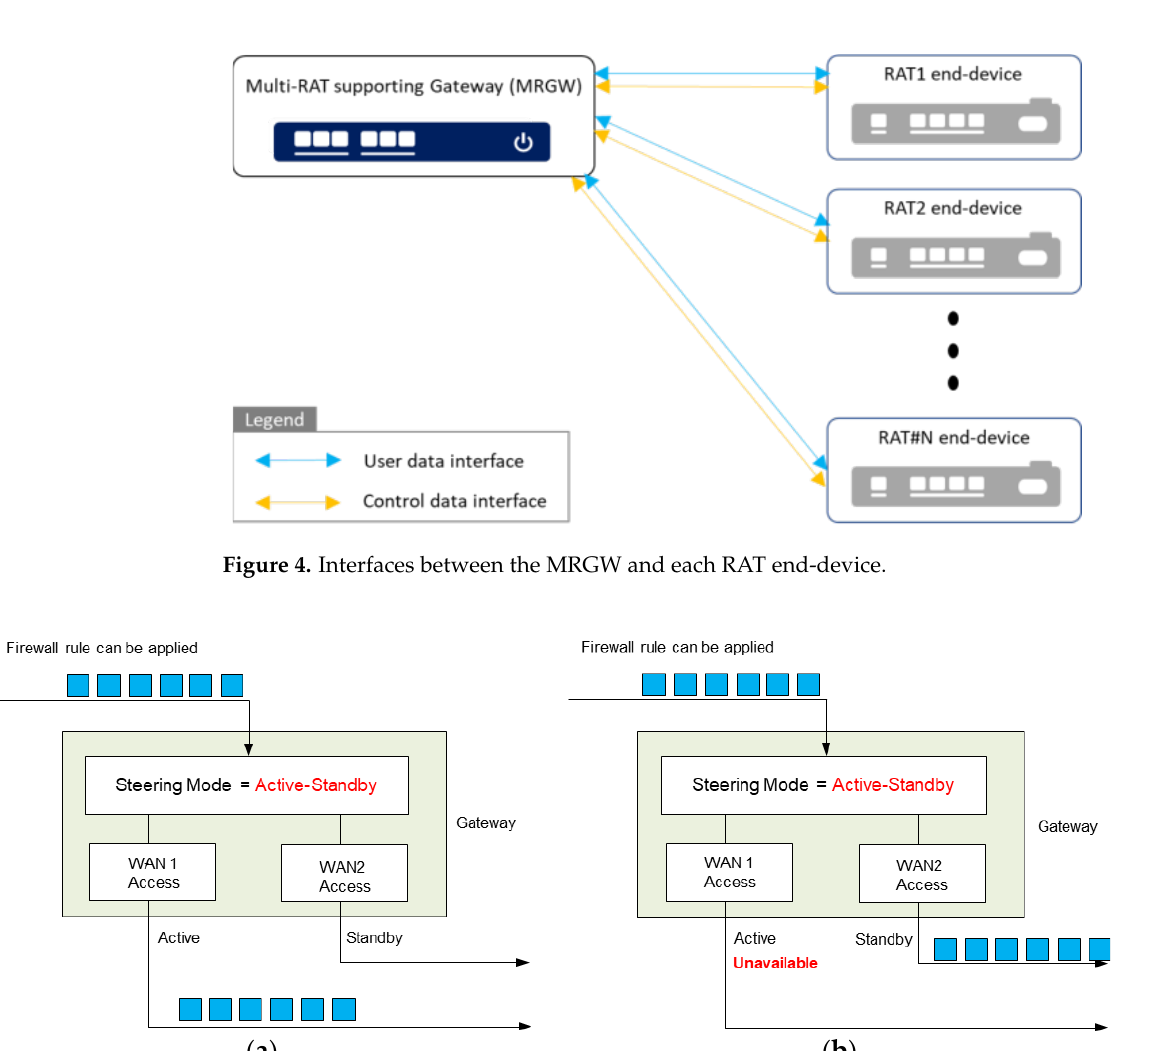
Figure 5. An example of traffic steering operation on Active Standby ( a ) Active access available; ( b ) Active access unavailable.